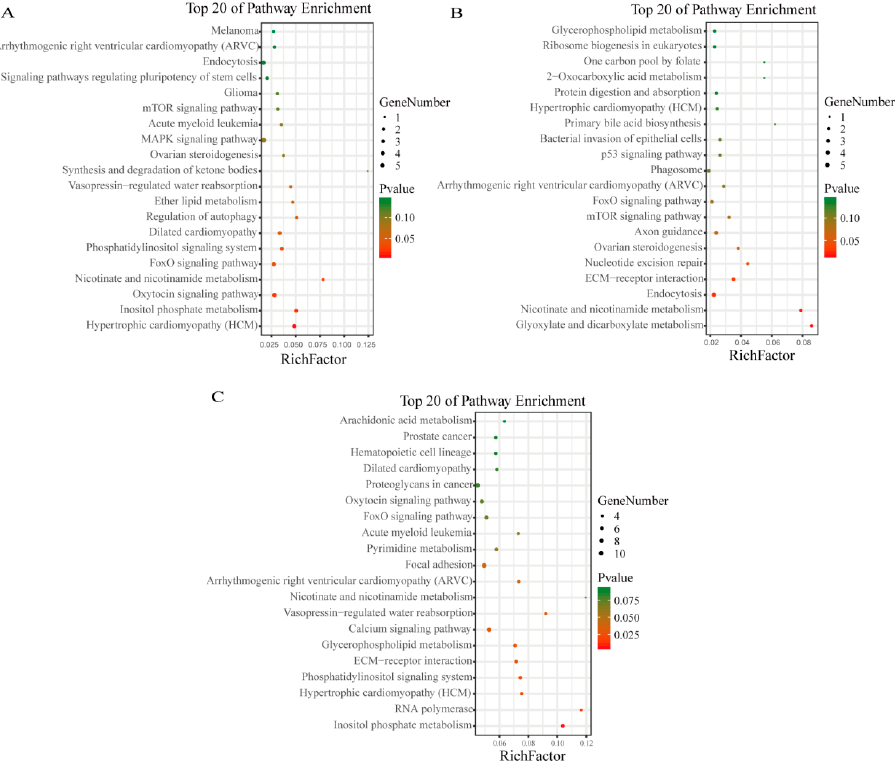
Figure 6. KEGG pathways of differentially expressed miRNA target genes in SS vs. SC ( A ), SR vs. SC ( B ), and SR vs. SS ( C ) groups. Table 4. The information of potential diarrheic resistance